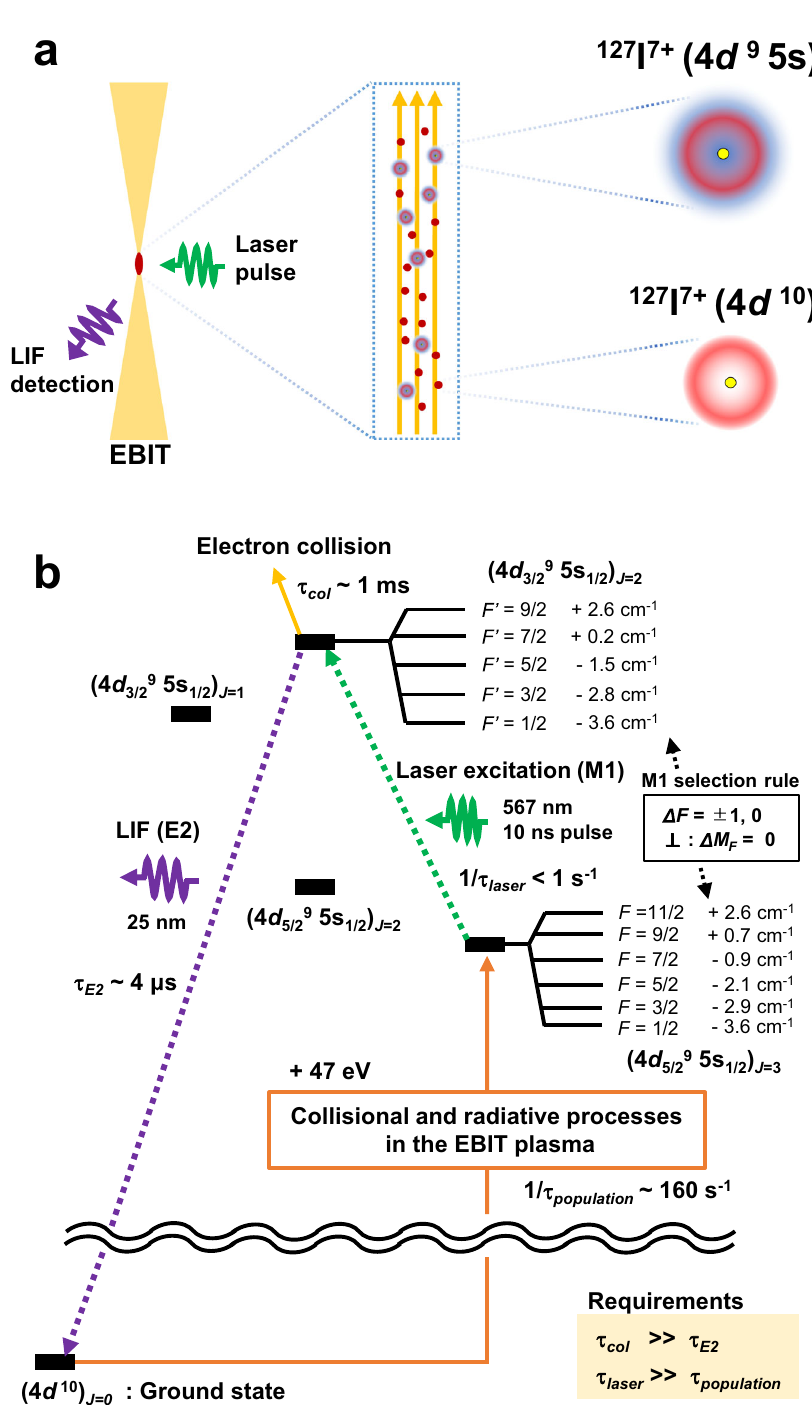
Fig. 1 Schematic diagram of the present laser spectroscopy. a Brief overview of the present laser-induced fl uorescence (LIF) spectroscopy with the schematic trap region and ions. b Experimental scheme with the energy diagram of 127 I 7 + . The population rate of (4 d 9 5 s ) J = 3 (1/ τ population ) was estimated, 5 = 2 using collisional-radiative modeling 49 . τ col , τ E 2 , and τ laser are depopulation lifetimes by electron collision, electric-quadrupole ( E 2) radiative decay, and laser- induced magnetic-dipole ( M 1) excitation, respectively. An electron energy of 105 eV and a density of 10 10 cm − 3 are assumed in the collisional-radiative rates, corresponding to the present experimental condition. The energy structure and lifetime were calculated using GRASP2018 41 Prediction of the spectral pro fi le . The hyper fi ne structures split corresponding to the difference from the original transition the laser transition into 14 components, considering the selection energy without the hyper fi ne structures. Figure 2b shows the rules for M 1 transitions ( Δ F = ±1, 0). Spectral simulations were spectral intensity gA , which is the sum of Einstein A coef fi cients performed to predict the features of the laser excitation spectrum, of the Δ m F = 0 transitions for every magnetic sub-level. We also calculated the Zeeman splitting using the intermediate magnetic including hyper fi ne structures. Figure 2a shows the statistical fi eld treatment, as shown in Fig. 2c. Equations and atomic codes weight of the initial state with the wavenumber deviation Δ k